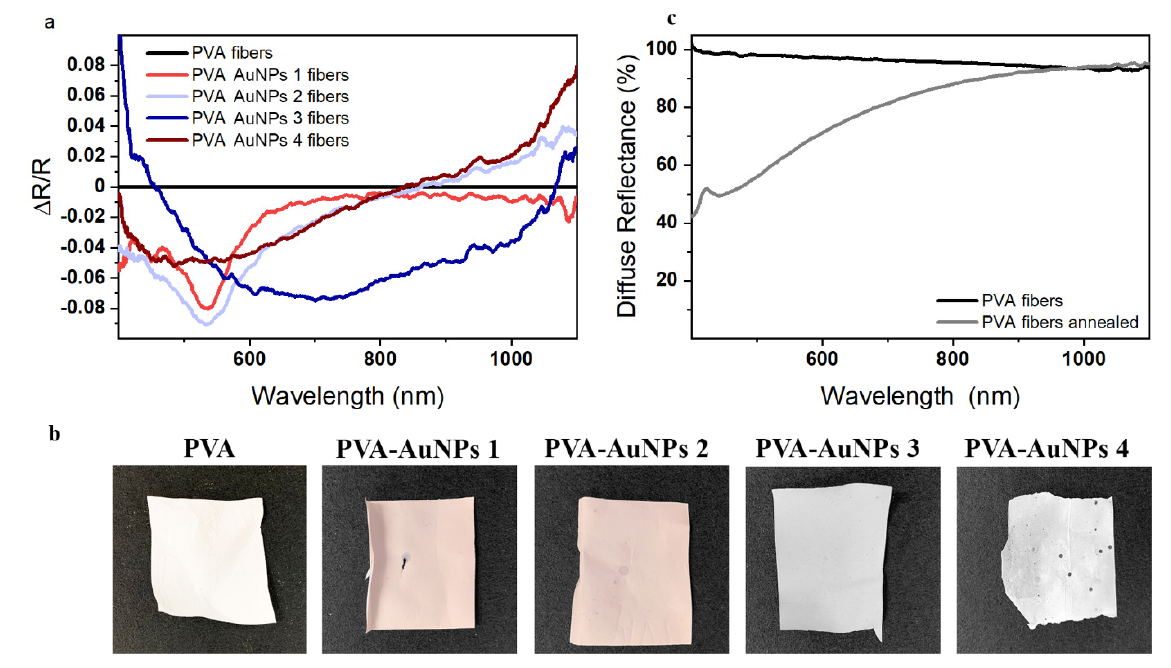
Figure 4. ( a ) Diffusive reflectance spectra of the as-prepared PVA-based membranes, ( b ) membrane digital photographs, and ( c ) comparison between the optical response before and after the thermal treatment for PVA fibers.